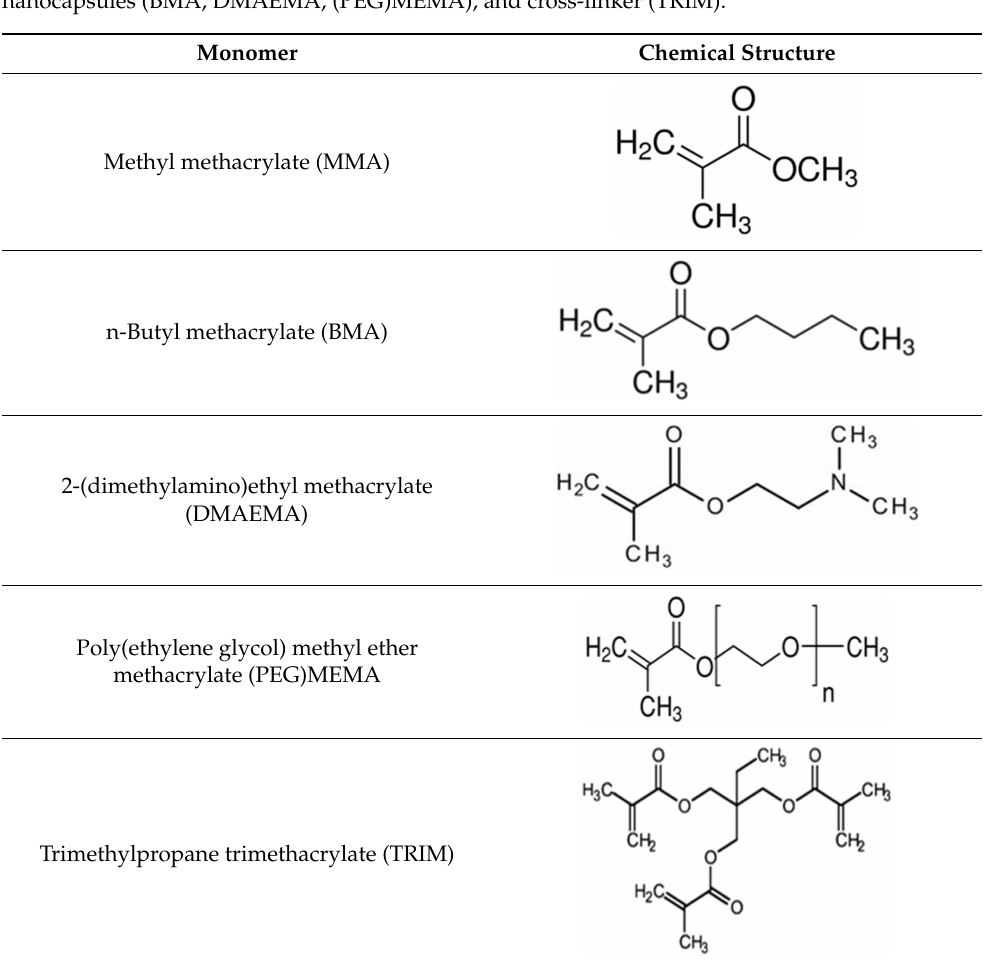
Table 1. Chemical structures of the monomers used for the synthesis of the sacrificial core (MMA), nanocapsules (BMA, DMAEMA, (PEG)MEMA), and cross-linker